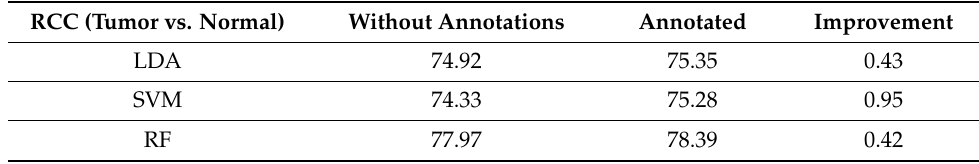
Table 1. Classification accuracies of the different supervised classification models using non- annotated renal cell carcinoma samples versus using the same dataset with histological annotations of the tumor